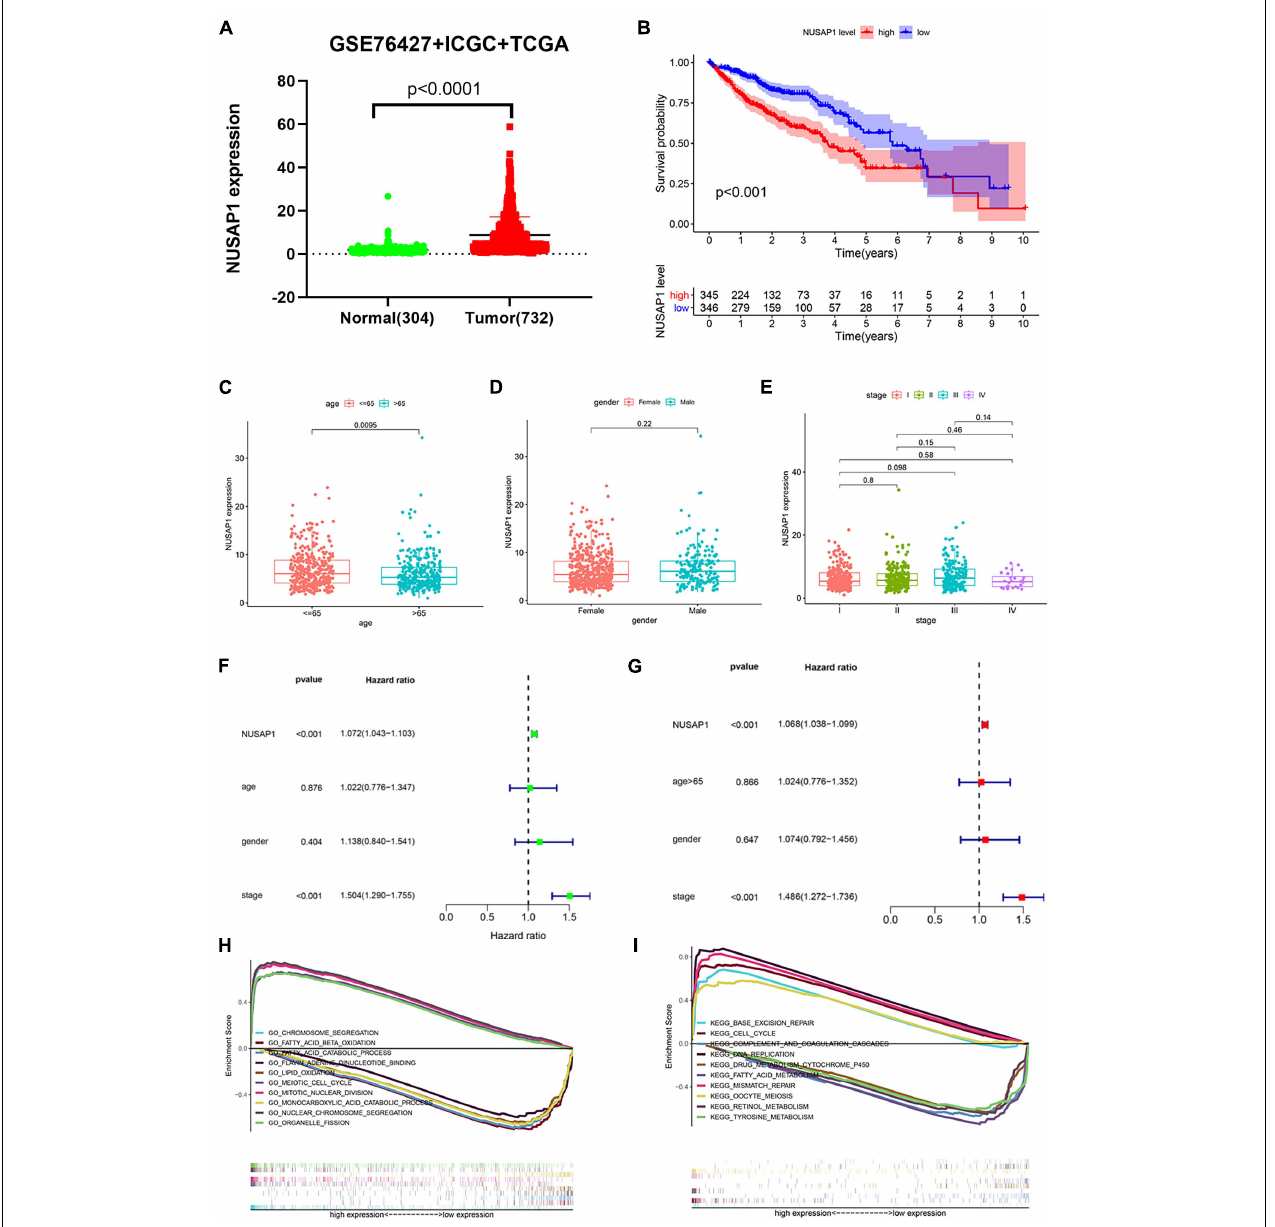
FIGURE 6 | Dot plot, Kaplan–Meier curve, box plots, forest plots, and GSEA enrichment analysis. All pictures were made by HCC patients’ expression and clinical information in GSE76427 dataset, ICGC database, and TCGA database. (A) Dot plot of NUSAP1 expression in normal samples and HCC samples. (B) Kaplan–Meier curve of OS analyzed between high NUSAP1 expression group and low expression group. (C) Bar graph of NUSAP1 expression in different age groups. (D) Bar graph of NUSAP1 expression in female and male. (E) Bar graph of NUSAP1 expression in different stage groups. (F) Univariate regression analysis. (G) Multivariate regression analysis. (H) GSEA enrichment analysis, which was based on GO gene sets. (I) GSEA enrichment analysis, which was based on KEGG gene